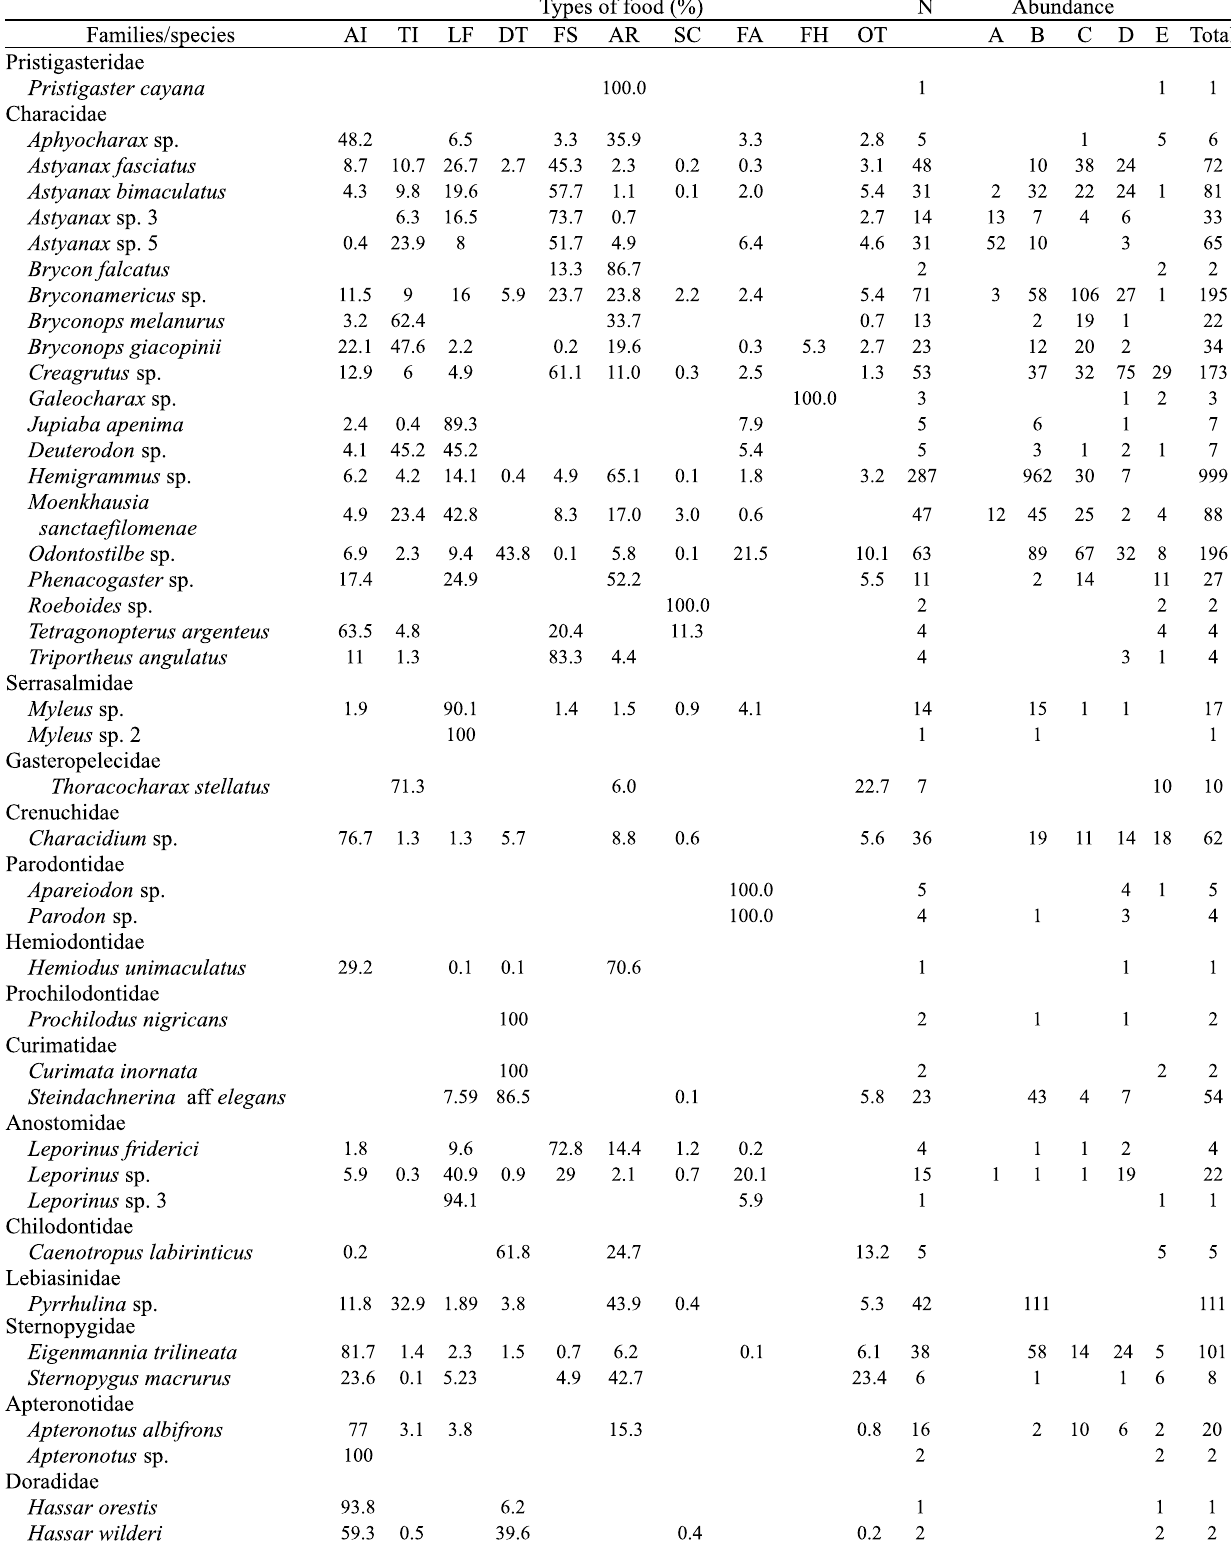
Table 1 . Relative volume (%) of the food items in the diet of fishes collected in the Córrego Fundo stream, between April 1994 and March 1995. (AI) Aquatic insects; (TI) terrestrial insects; (LF) leaves and flowers; (DT) detritus; (FS) fruits and seeds; (AR) arthropod remains; (SC) scales; (FA) filamentous algae; (FH) fish; (OT) others; N = number of individuals analyzed. Species with empty stomachs were not included in this table. The taxonomical order is adapted from Britski et al .